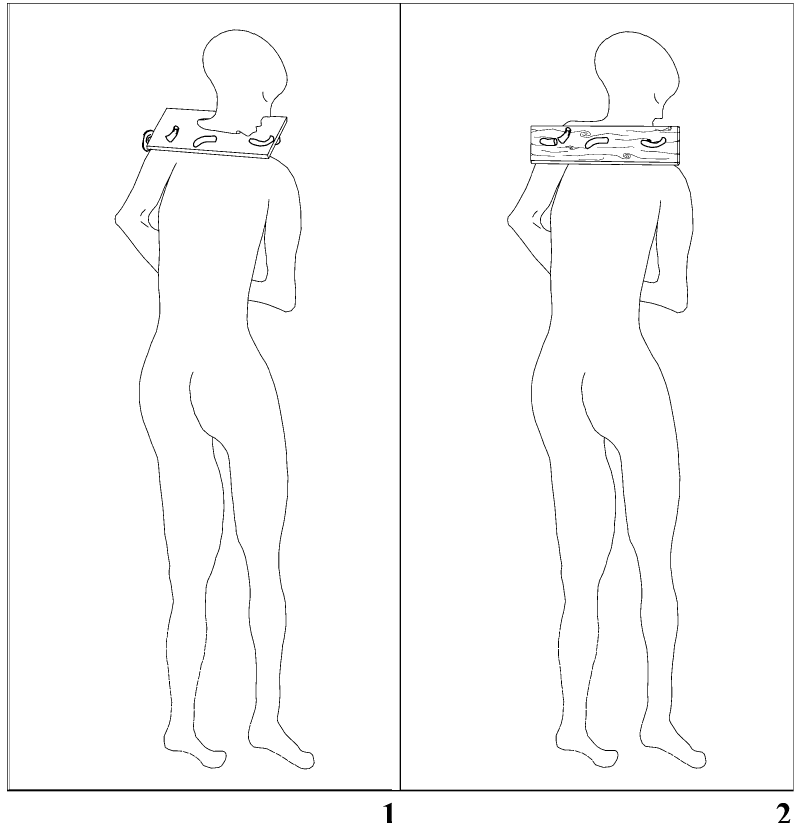
Figure 9: Carbonara Scrivia, tomb no. 1. Hypothetical reconstruction of the restriction system: 1) physical restriction (yoke?) 2) symbolic restriction (the device is only placed on the body, without securing physically the corpse’s neck and shoulder (drawing Laura Marchi © Soprintendenza Archeologia del